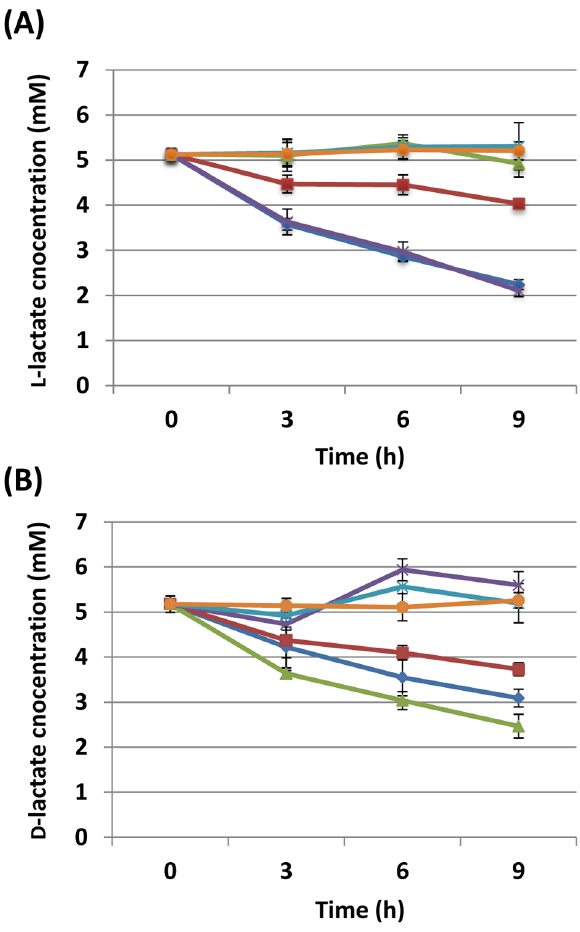
Figure 3. Concentrations of L-lactate (A) and D-lactate (B) in culture supernatants of H.pylori 26695 wild type and isogenic mutants. Exponentially growing 26695 wild type (blue), the D 140 mutant (red), the D 138 mutant (green), the D 1222 mutant (purple), the D 138/ D 1222 mutant (aqua), as well as blank medium (orange) were incubated with 5 mM L- or D-lactate, and lactate concentrations were determined by biochemical assay kits as in Materials and Methods. The data points and error bars represent the means 6 SD of three independent experiments.